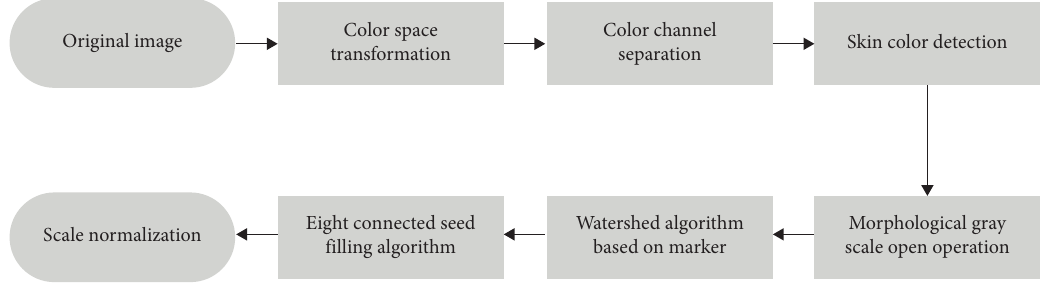
Figure 1: Preprocessing processes of gesture recognition.